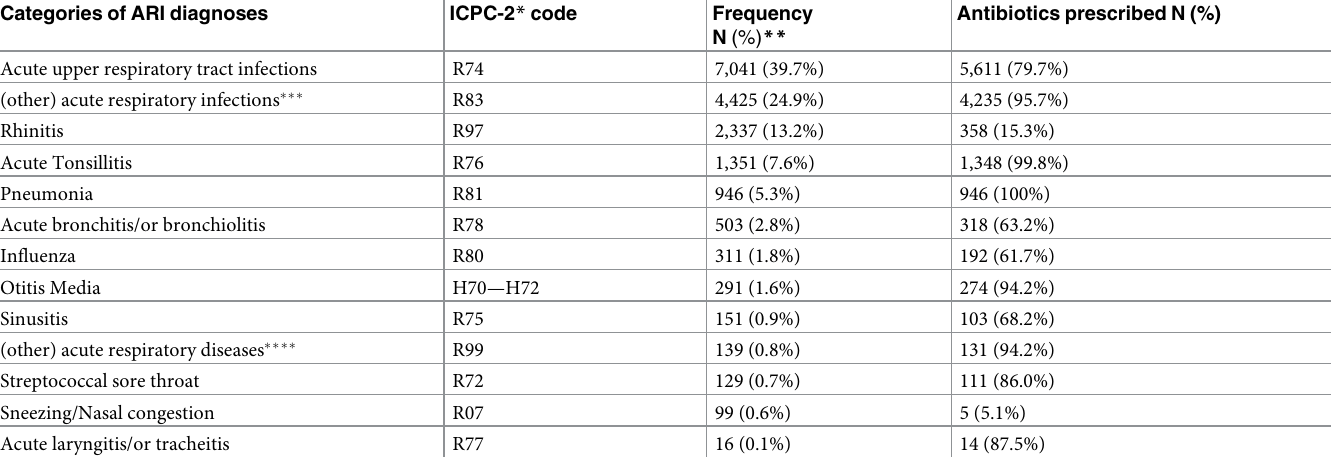
Table 2. Types of ARI diagnoses and disease-specific antibiotic prescription at the study clinics between April 1 and December 27, 2016 in Nairobi, Kenya (N = 17,739 ARIs). Categories of ARI diagnoses